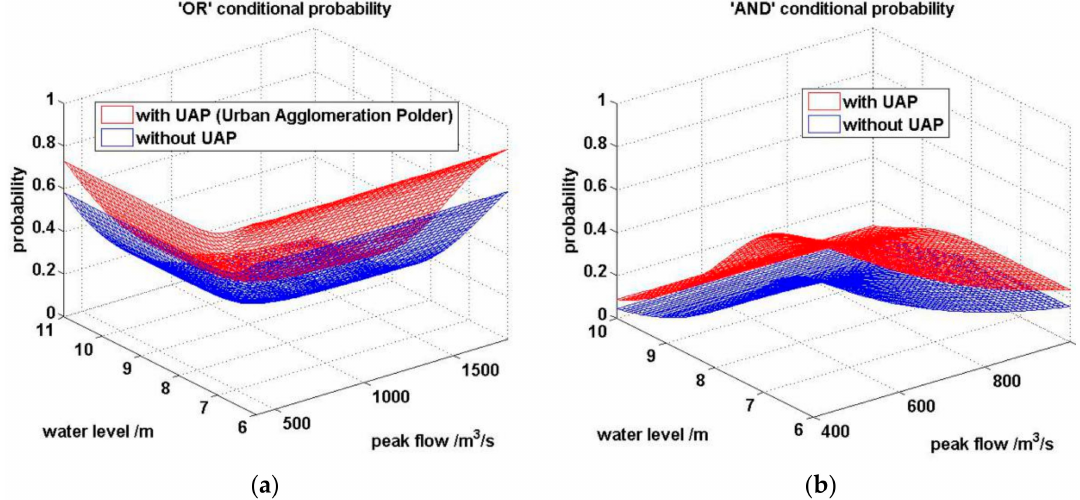
Figure 5. Two conditional probabilities of flood volume <300 m 3 : ( a ) ‘OR’ conditional probability of flood volume <300 m 3 ; ( b ) ‘AND’ conditional probability of flood volume <300 m 3